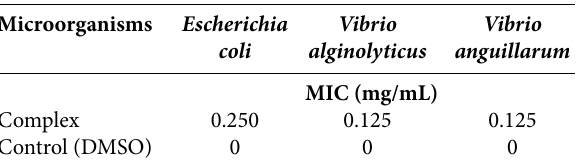
Table 5. Minimum Inhibitory Concentration assay of metal com- plex against bacterial pathogens